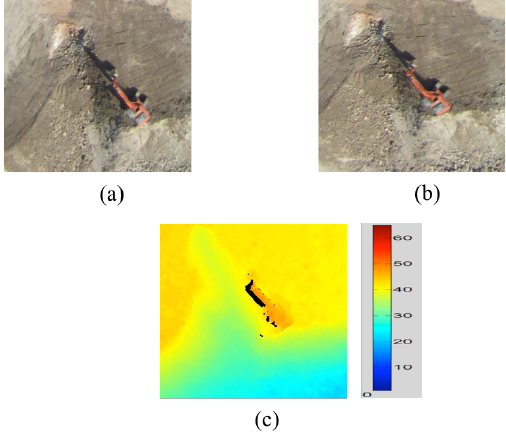
Figure 5. First (a) and second (b) image of the object of interest, and disparity map (c) -lower values tend to dark blue, higher values to dark red, and occlusions are depicted in